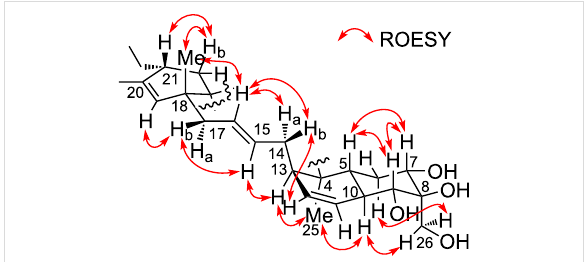
Figure 3: Relative configuration of 1 determined by ROESY analysis.